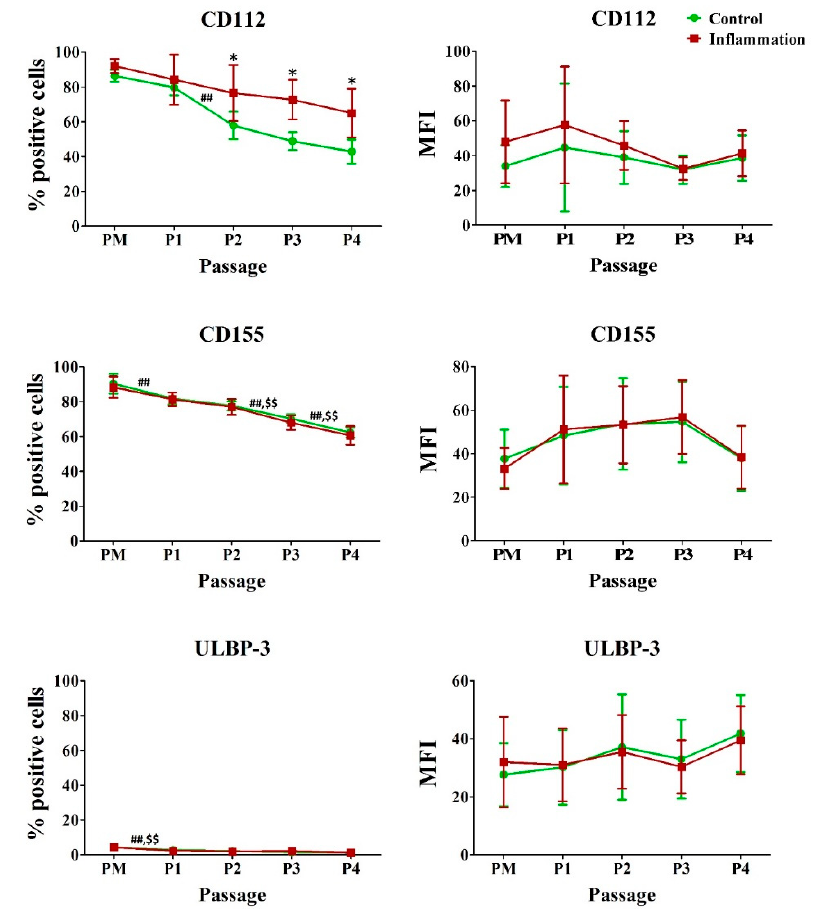
Figure 6. Impact of inflammation and cell passaging on the expression of natural killer ligands in AT-MSCs. Flow cytometric analysis was used to determine the percentage of positive cells and the protein expression per cell (MFI). The values are expressed as mean ± SD and originate from six different AT-MSC donors. * Significantly higher percentage or amount per cell in inflammation-stimulated AT-MSCs compared to regular AT-MSCs ( p -value < 0.05). ## Significantly lower percentage or amount per cell in regular AT-MSCs compared to the consecutive passage ( p -value < 0.05). $$ Significantly lower percentage or amount per cell in inflammation-stimulated AT-MSCs compared to the consecutive passage ( p -value <